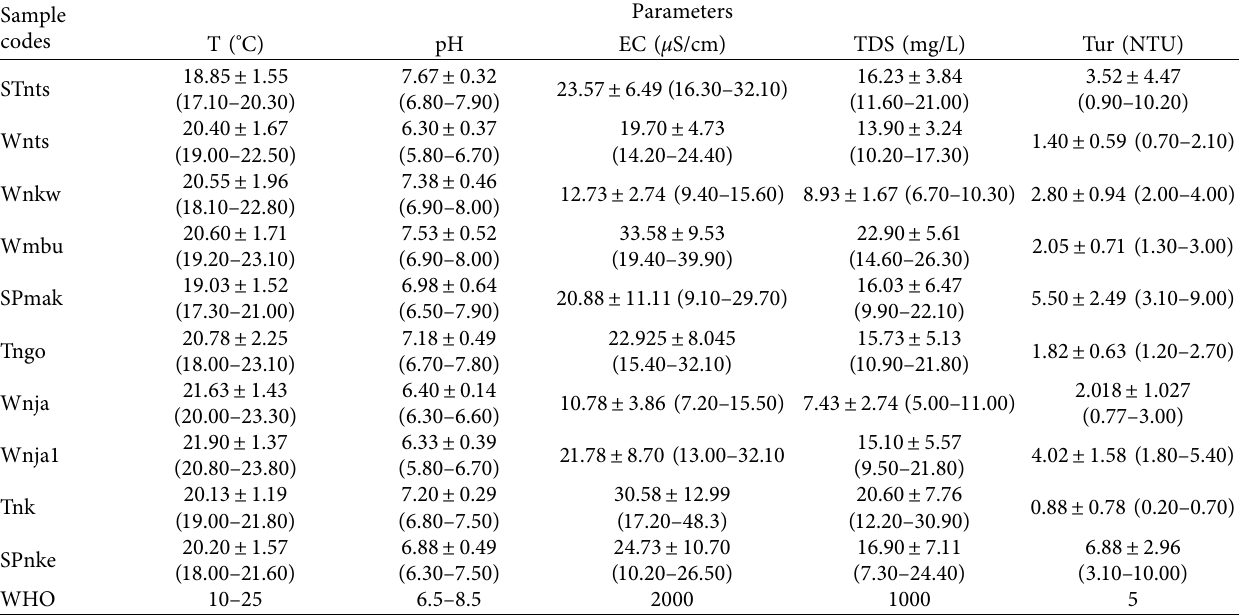
Table 2: Physical parameters of samples from ten water sources in Bangolan within the study